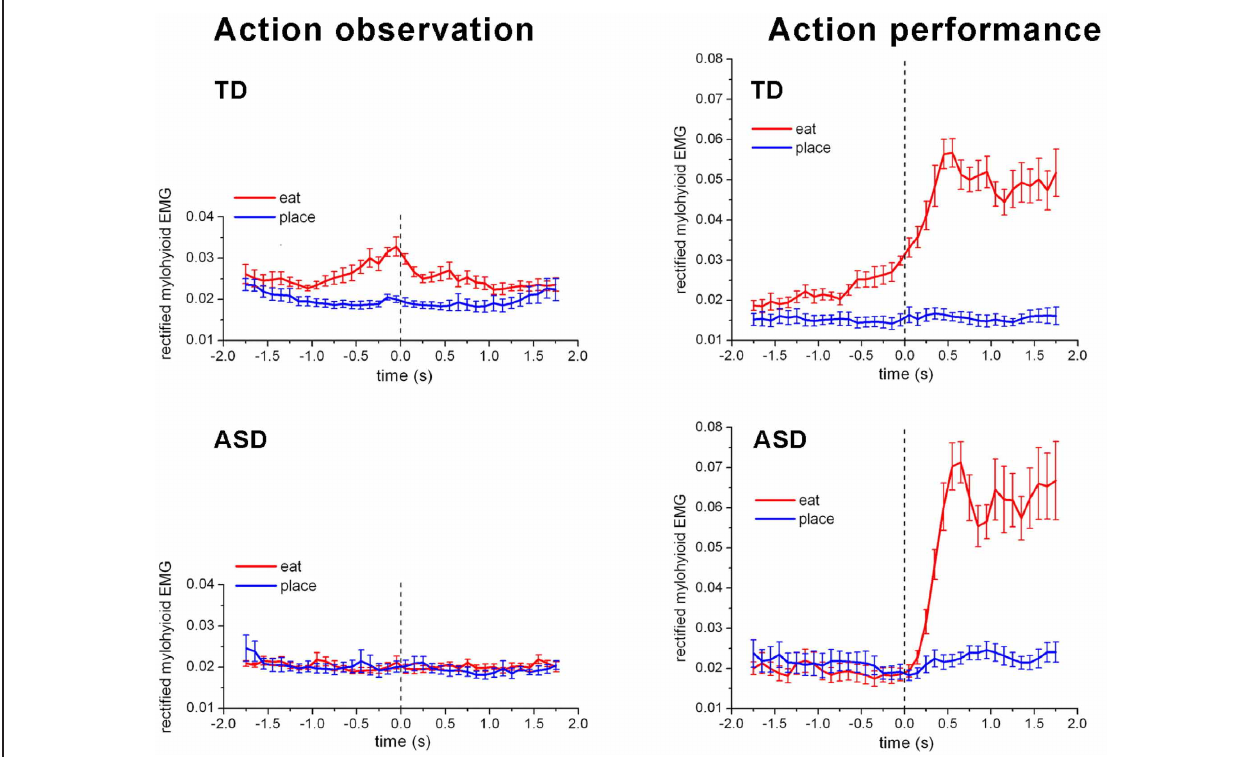
FIGURE 1 | The activation of the mylohyioid muscle during the event of bringing the food to the mouth (red) and the paper to the container (blue) in the TD children and the children with ASD. Zero is the time of grasping. [From Cattaneo et al., PNAS, Copyright (2007) National Academy of Sciences,